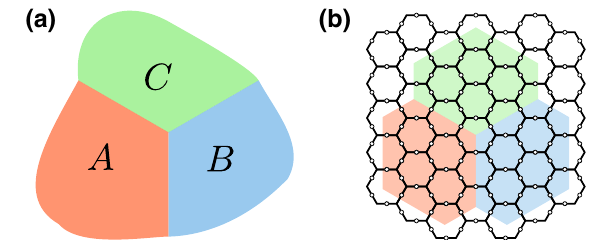
FIG. 4. Probing the TEE on a quantum computer. (a) The sim- ply connected domains A , B , and C are used in the subtraction procedure given in Eq. (7); the exterior is the rest of the system. (b) A connected domain on a honeycomb lattice for extracting the TEE. The domain includes the qudits on the external legs, while the qudits on the boundary of two domains are shared by both sides.